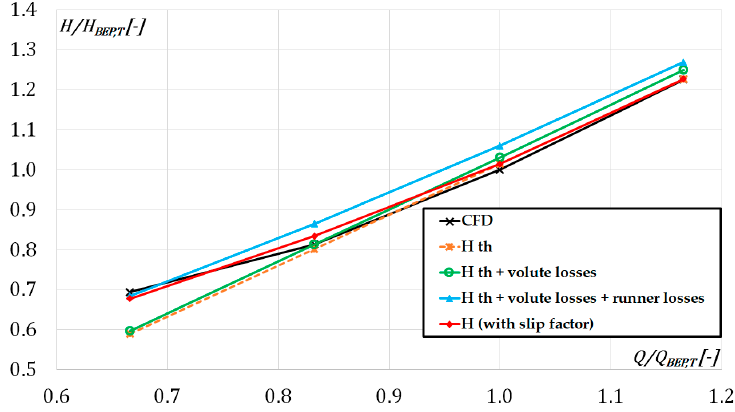
Figure 26. Comparison of different sources of losses for the performance prediction.